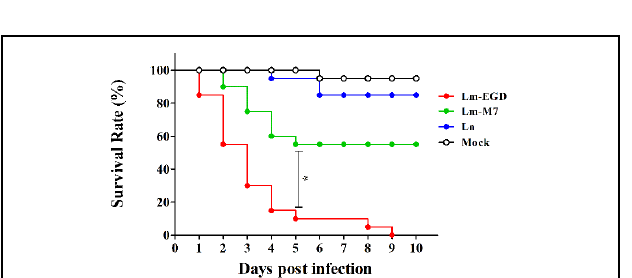
brain ventricle injection. * P <